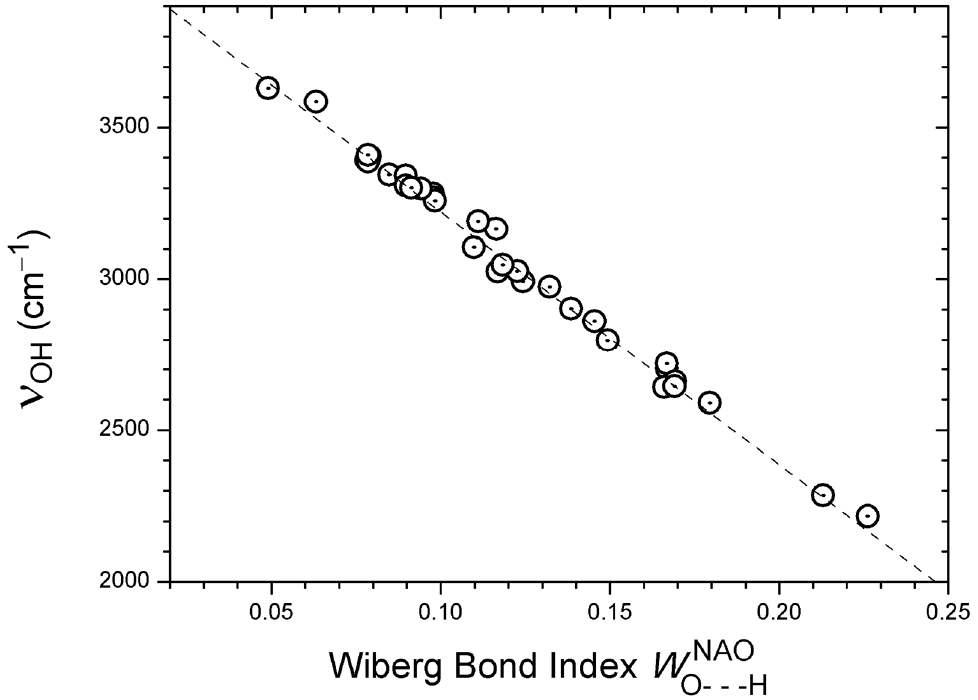
Figure 3. Correlation of calculated harmonic ν OH wavenumbers with computed Wiberg bond indices for the corresponding H···O distances, considering 33 OH···O=C systems (see text). The regression line is Y = 4057.6 − 8257.546 · X (33 pts: R = − 0.996, SD = 30 cm − 1 ).